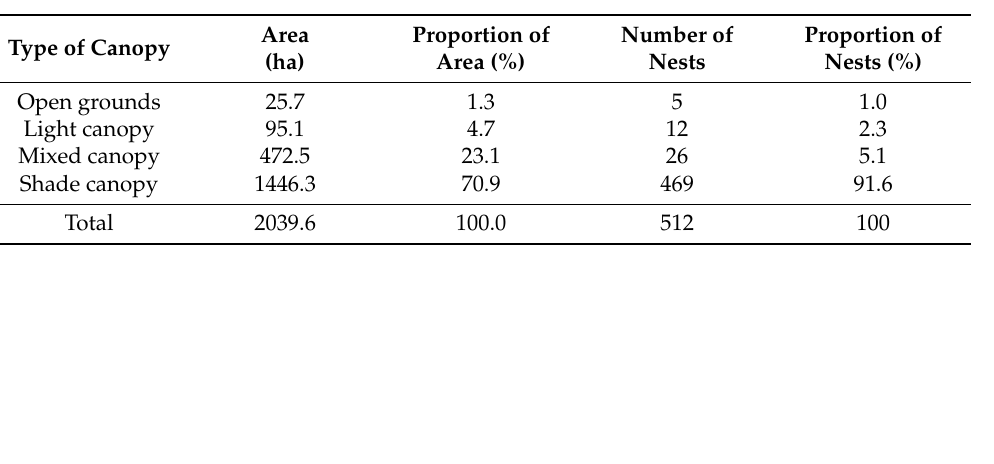
Table A3. Distribution of RWA in 2018 according to type of canopy derived from tree species composition (cf.